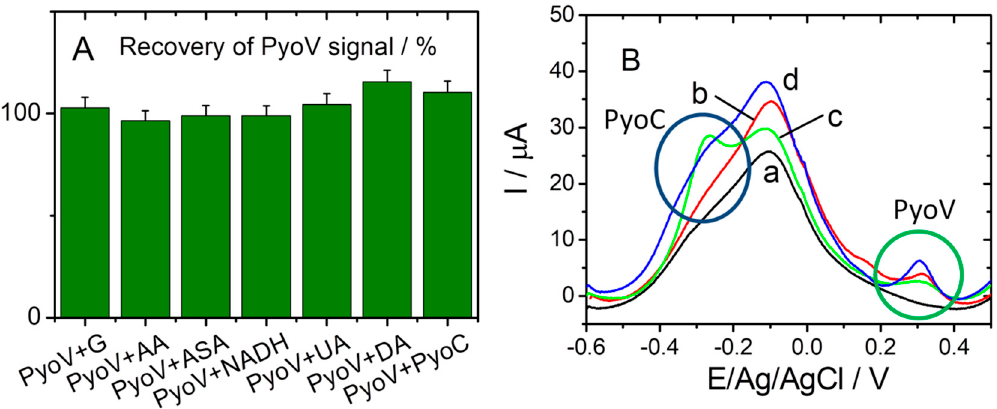
Figure 6. ( A ) The selectivity of the sensor for PyoV over other analogs G, AA, ASA, NADP, DA, UA, and PyoC. ( B ) DPVs registered in 20 mM PBS pH 7.4 (black (a)), 25 µM PyoV (red (b)), 10 µM PyoC (green (c)), and 25 µM PyoV+10 µM PyoC (blue (d)). The oxidation peaks for PyoV and PyoC are highlighted in ( B ) with green and blue circles, respectively.